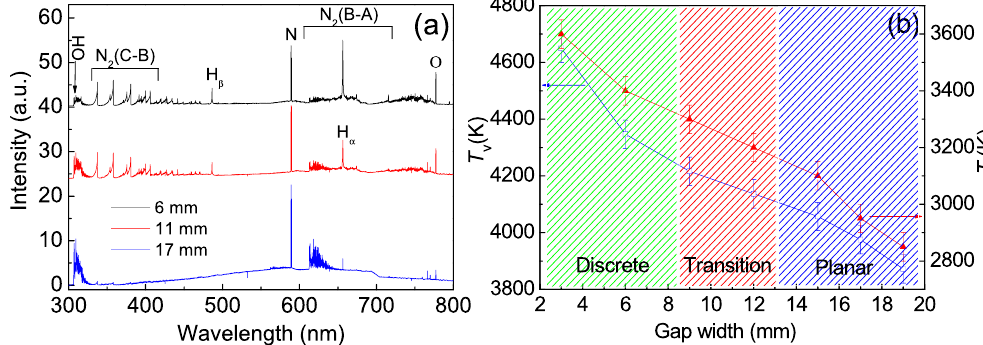
Figure 5. ( a ) Optical emission spectra from the positive columns of the discharges with a gap width of 6 mm (on the top), 11 mm (in the middle) and 17 mm (at the bottom), respectively. ( b ) Vibrational temperature and rotational temperature as functions of the gap width.